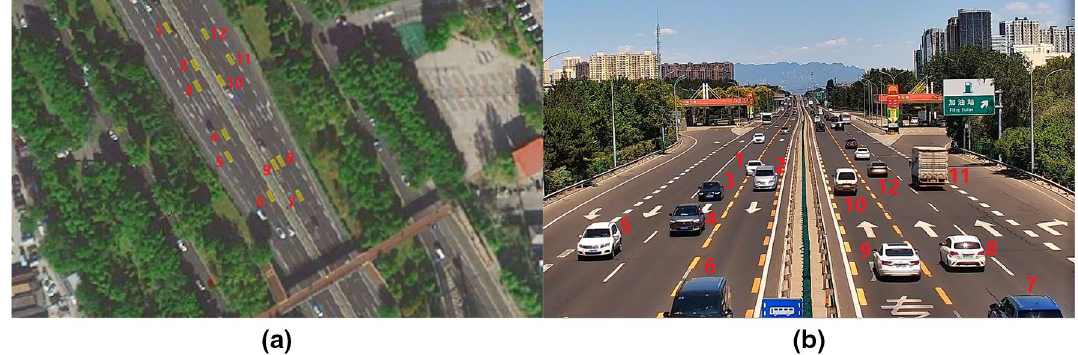
Figure 11. DT model of the experimental highway scenario. ( a ) Car flow DT in satellite map, ( b ) Scenario video in the same